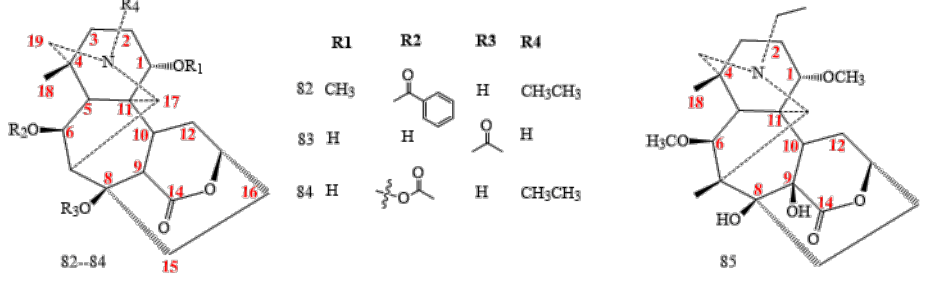
Figure 7. C 19 -lactone